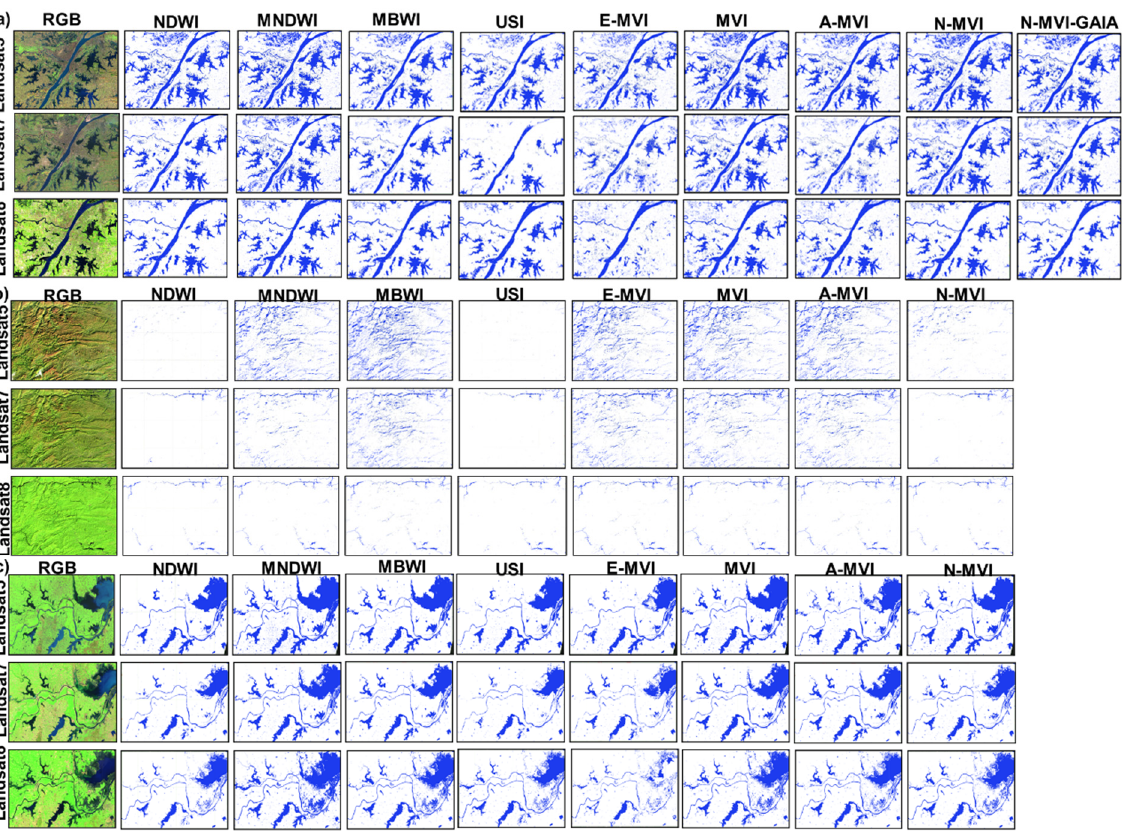
Figure 6. Performance of the 8 water body algorithms applied to different images of Landsat 5/7/8 in the city ( a ), mountainous areas ( b ) and rice fields ( c ). The RGB images of Landsat correspond to the shortwave infrared-1, near infrared and red bands, respectively.